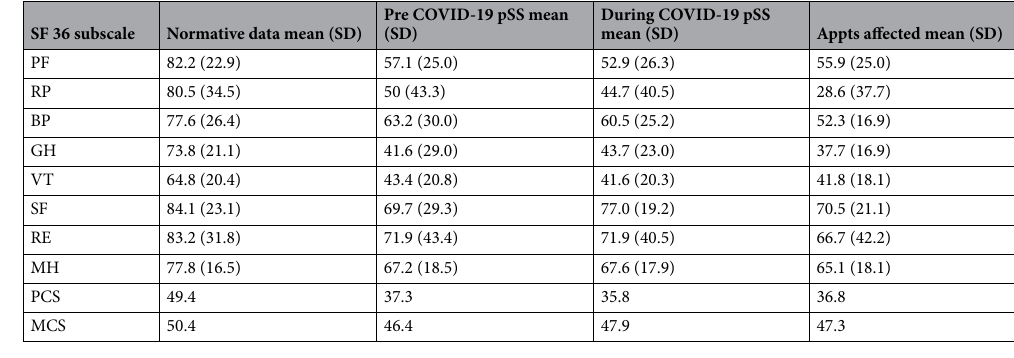
Table 3. SF-36 subscale results (mean ± SD) and component summaries from normative data and from those with pSS, including pre-COVID-19, during COVID-19, and the results of those whose appointments had been cancelled, delayed or reschedule during the pandemic. PF, physical function; RP, role limitation due to physical health; BP, bodily pain; GH, general health; VT, vitality; SF, social function; RE, role limitation due to emotional health; MH, mental health; PCS, physical component summary; MCS, mental component summary.